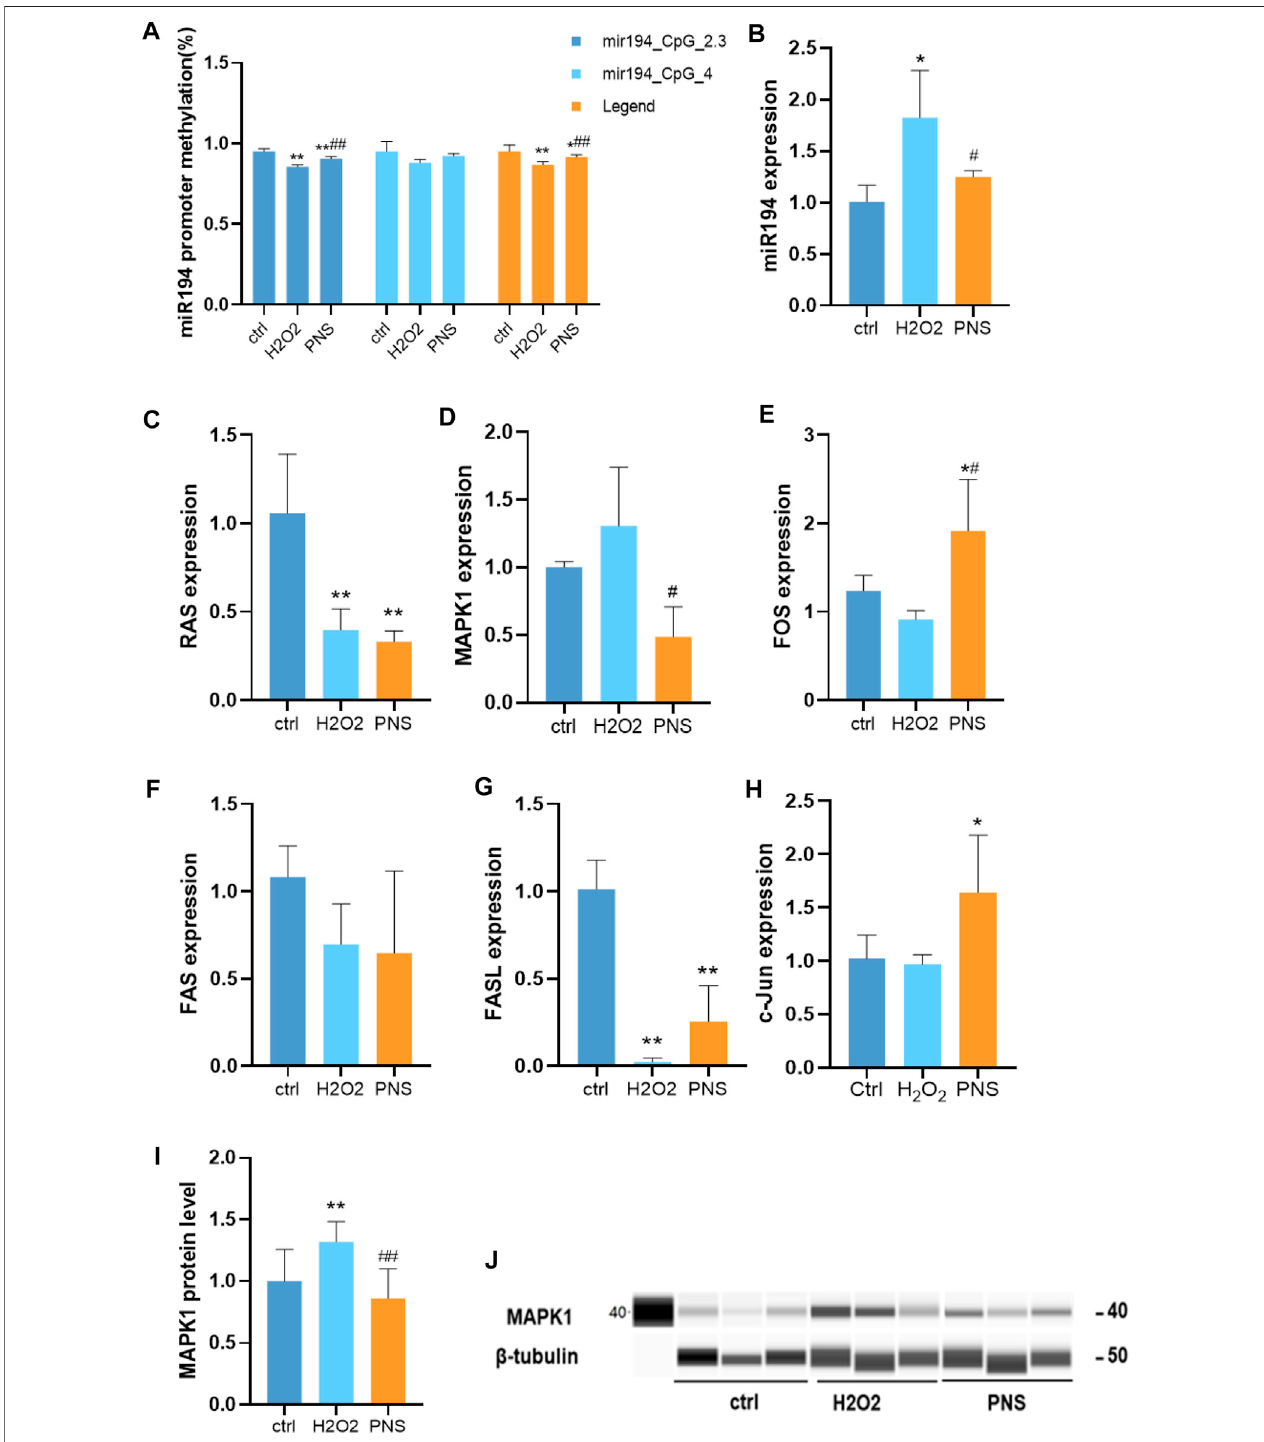
FIGURE 7 | Expression of key genes in the miR-194 promoter-miR-194-MAPK pathway by MSPCR, qRT-PCR, and Western blotting in vitro (A) DNA methylation level of the miR-194 promoter by MSPCR; (B) miR-194 expression; (C) RAS expression; (D) MAPK1 expression; (E) FOS expression; (F) FAS expression; (G) FASL expression; (H) c-Jun expression; (I) MAPK1 protein level; and (J) MAPK1 protein.